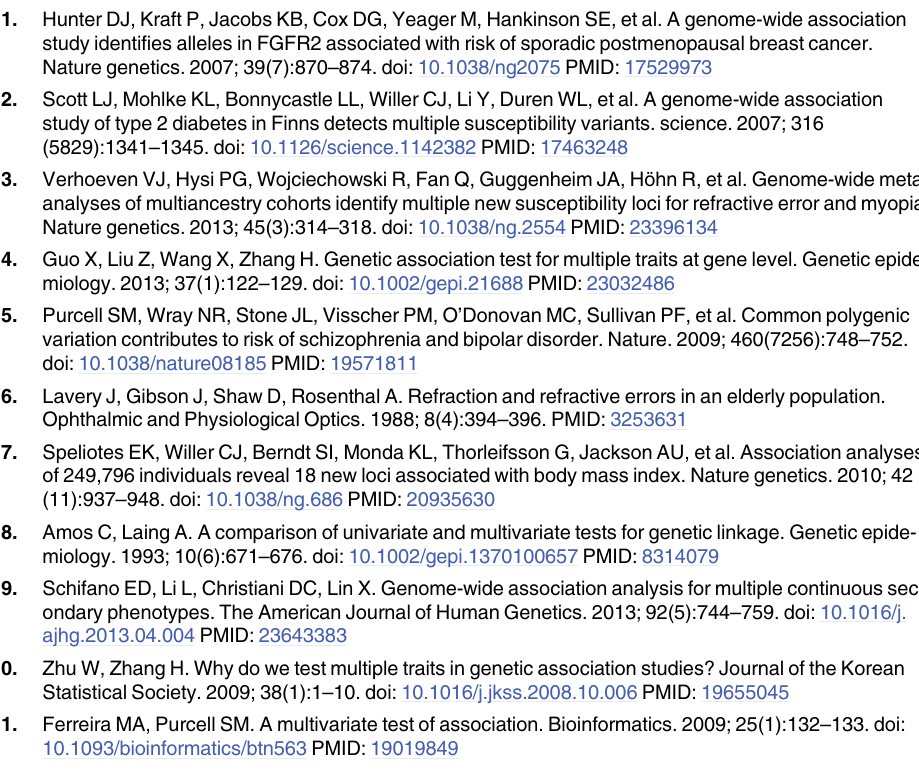
S1 Table. Type I error of the multiple phenotypes association tests when the phenotypes are five and ten, respectively. The nominal significance level is set to be 5 × 10 − 4 , and the sam- ple sizes are set to be 300, 500 and 100, respectively. S2 Table. P-values from association tests of 38 candidate SNPs by jointly analyzing CYL and